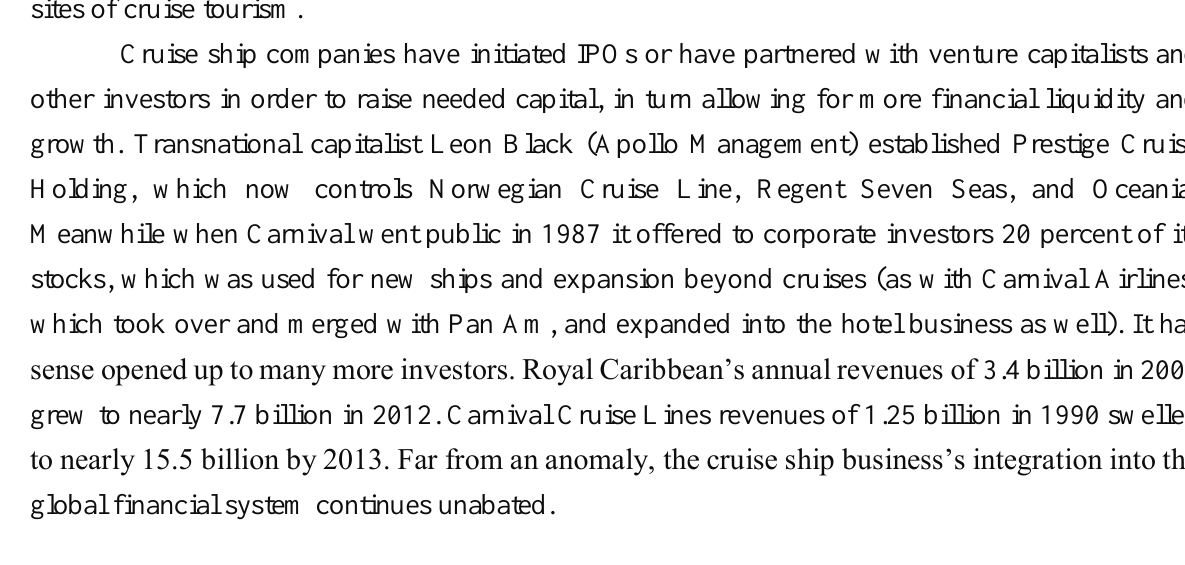
Figure 2. Revenue (millions), Carnival Cruise Lines,